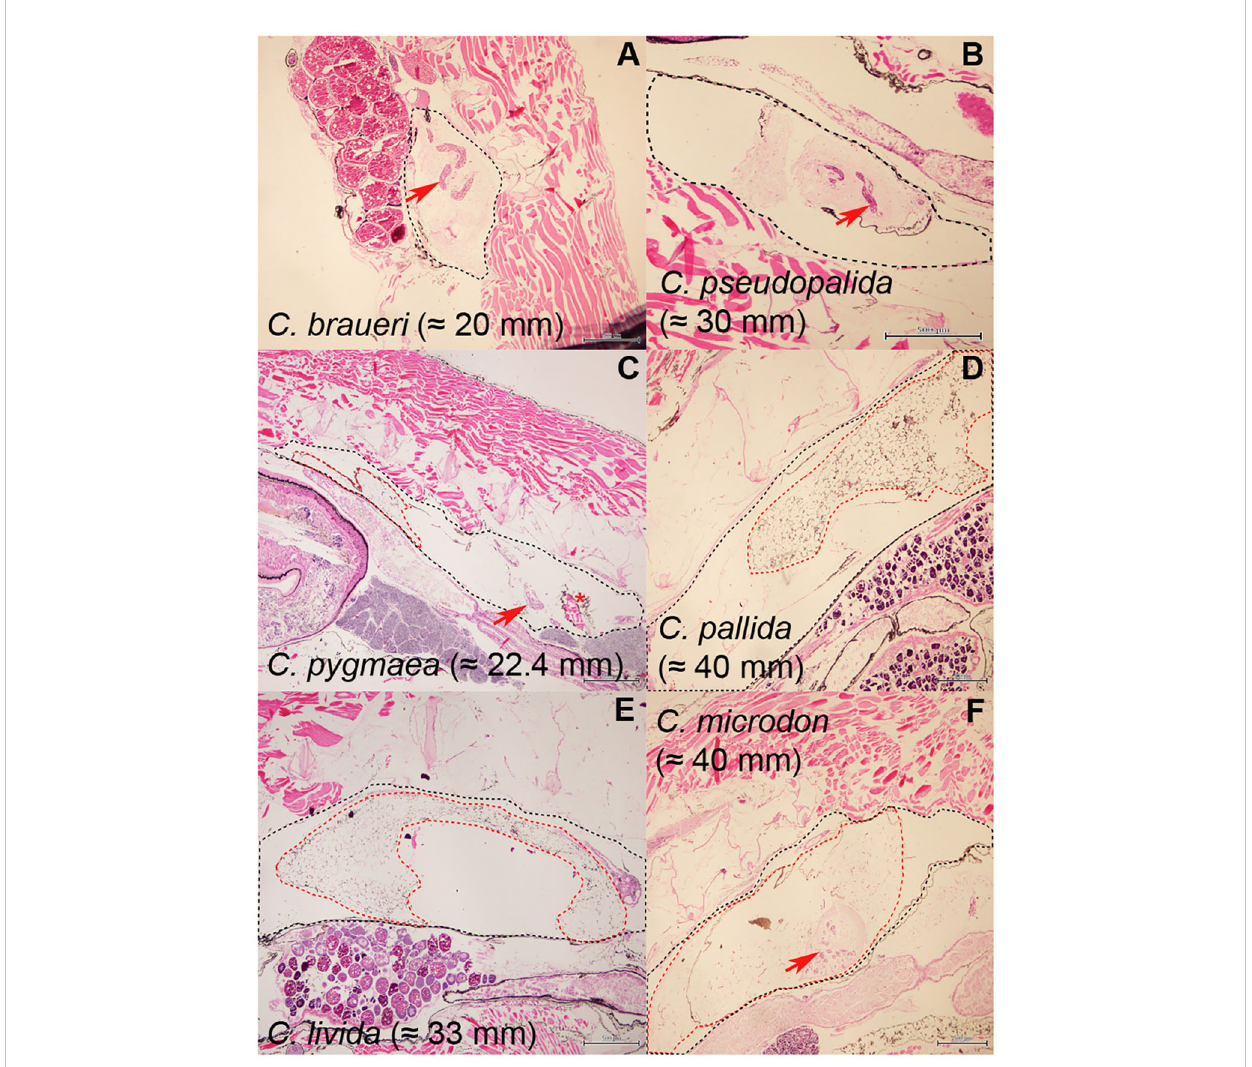
FIGURE 6 Histological sections of (A) C. braueri and (B) C. pseudopallida and for deeper species ( (C) C. pygmaea , (D) C. pallida , (E) C. livida , and (F) C. microdon ). The asterisk indicates the Gas gland, and the arrow the rete mirabile. The black contour delineates the swimbladder and the red contour the fat